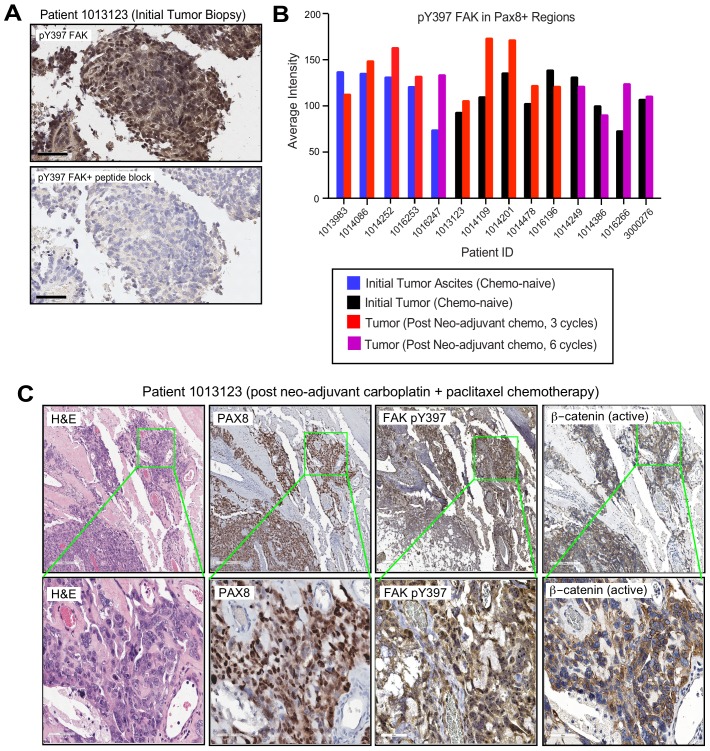
FAK pY397 phosphorylation is maintained in Pax8-positive HGSOC tumors after neo-adjuvant chemotherapy.(A) pY397 FAK staining with hematoxylin of initial tumor biopsy (patient 1013123) with or without addition of a pY397 FAK phosphopeptide. Scale is 60 µm. (B) Comparison and quantitation of pY397 FAK staining (Aperio software) within Pax8-positive regions of initial (chemo-naive) and post-neoadjuvant chemotherapy tumor biopsies. Values are means, samples are denoted by patient ID from initial tumor biopsy (black bars for solid tumor and blue bars for tumor ascites) or after neo-adjuvant chemotherapy (red is three cycles and purple is six cycles of chemotherapy). 11 regions were analyzed per tumor section. Tumor and chemotherapy details in Figure 3—figure supplement 1. (C) Serial OC tumor sections obtained after neo-adjuvant chemotherapy (patient 1013123, six cycles) were stained with H and E, Pax8, pY397 FAK, and active β-catenin. Counter-stained with hematoxylin. Scale is 200 µm. Inset (green box) region is shown magnified (below, scale is 60 µm).